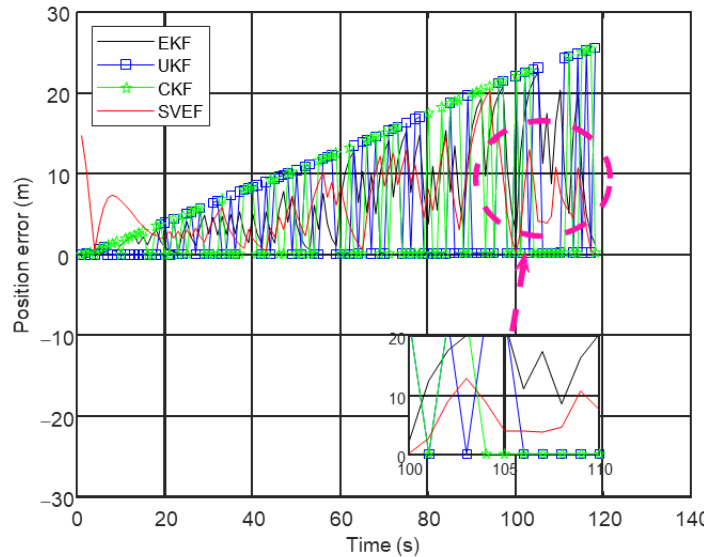
Figure 5. Position errors for different algorithms.